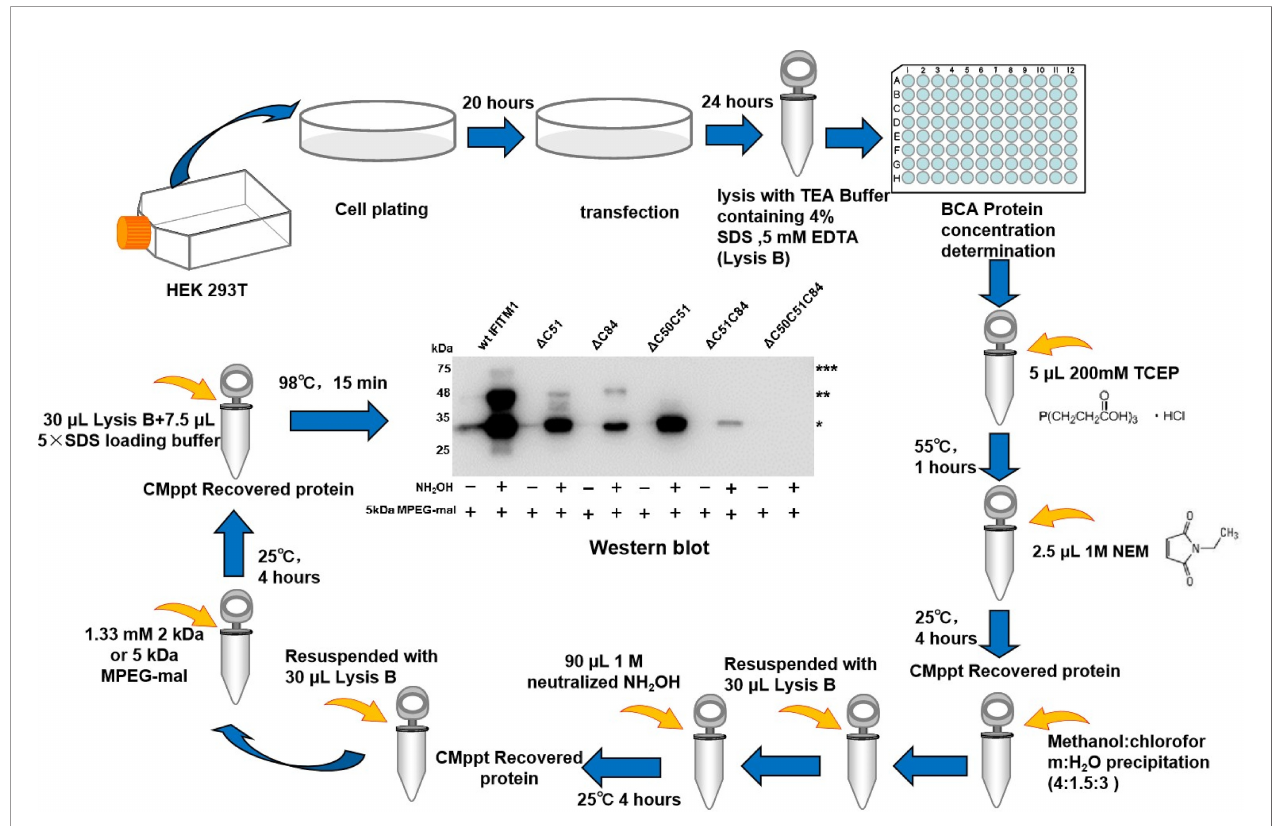
FIGURE 3 | The diagram of the detailed procedures of APEGS for cell